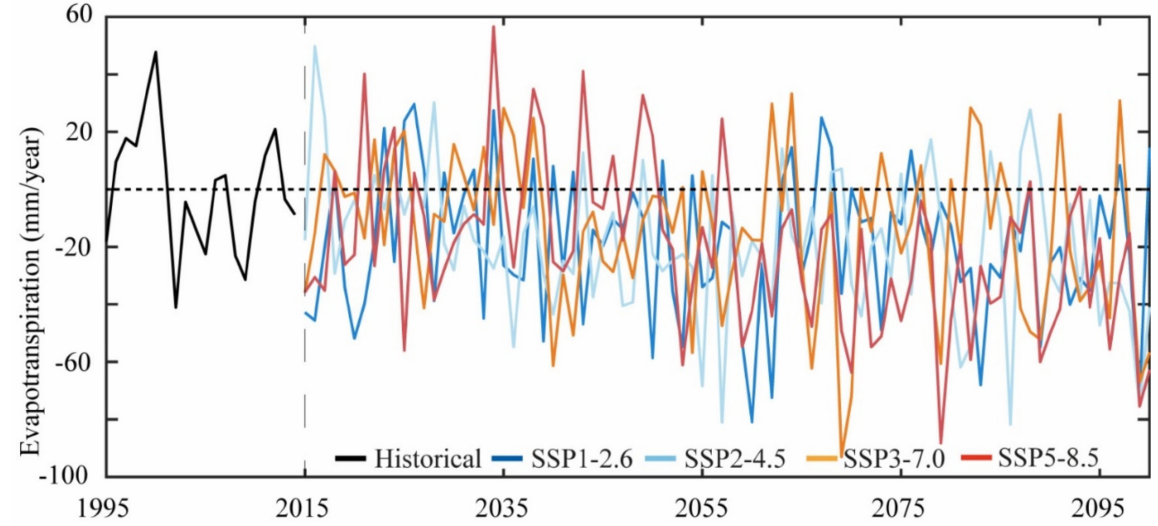
Figure 2. The annual ET in the historical period (1995–2014) and future period (2015–2100) under SSP1-2.6, 2-4.5, 3-7.0, and 5-8.5 scenarios relative to the historical